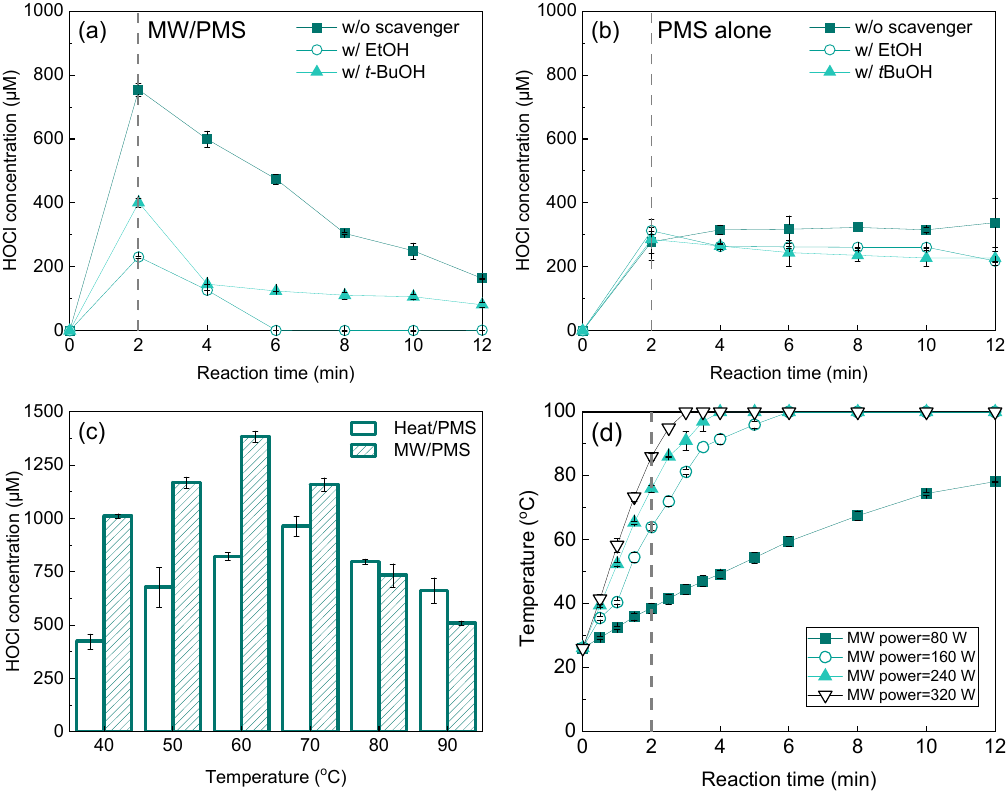
Figure 2. Effects of t BuOH and EtOH on the HOCl concentration in ( a ) MW/PMS and ( b ) PMS-alone systems in high-Cl − background matrix, ( c ) comparison on the HOCl concentration of Heat/PMS and MW/PMS processes, and ( d ) effect of reaction temperature on HOCl concentration in MW/PMS and PMS-alone systems. Reaction conditions: MW power = 160 W, [PMS] 0 = 10 mM, [Cl − ] 0 = 17.00 mM, [ t BuOH] 0 = 100 mM, [EtOH] 0 = 100 mM, and reaction time = 8 min.